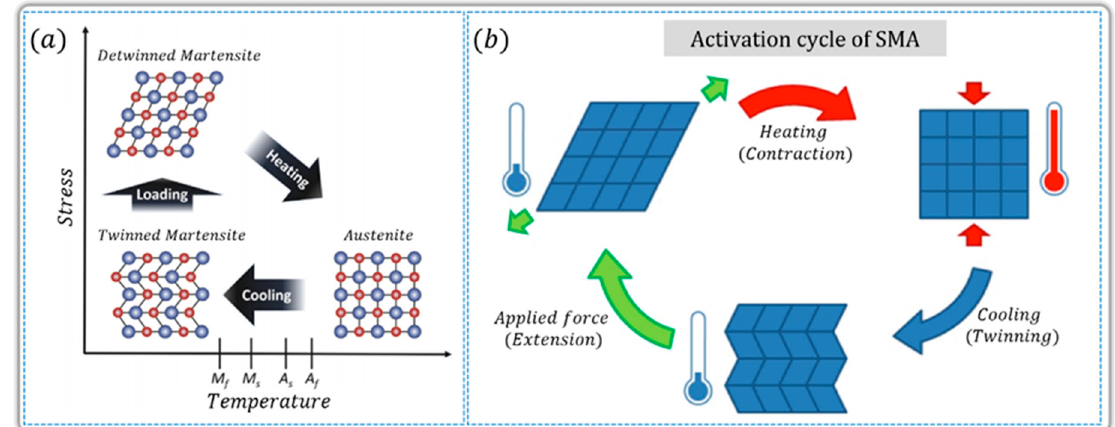
Figure 2. ( a ) Phase transition behavior of SMAs, adapted with permission from [18], Elsevier, 2016. ( b ) Activation cycle of SMAs under the influence of temperature, adapted with permission from [19], IEEE, 2014. (Note: A f = Austenite finish temperature, A s = Austenite start temperature, M s = Martensite start temperature, and M f = Martensite finish temperature).